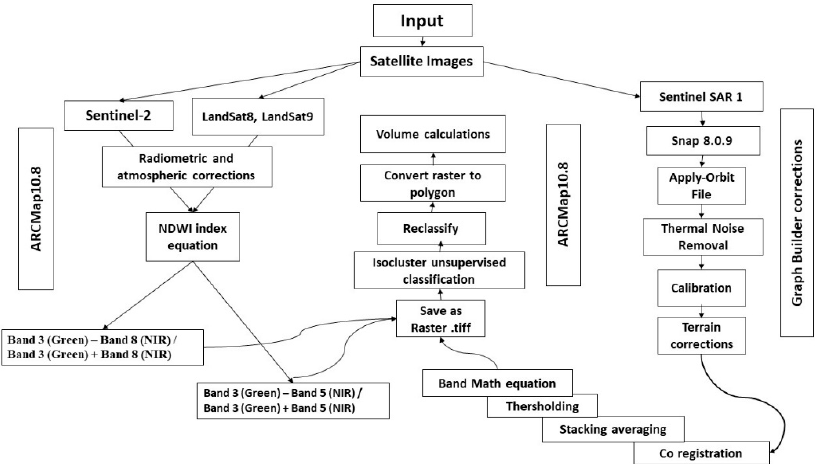
Figure 2. Workflow explaining the steps of satellite image analysis carried out in this study to calculate the volume of the GERD Lake.